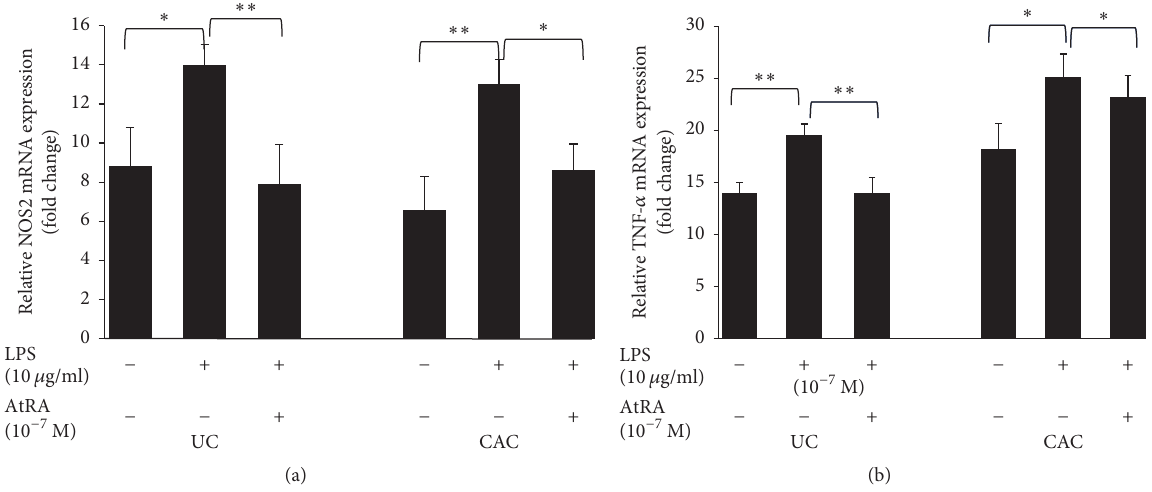
Figure 11: Effect of LPS (10 𝜇 g/ml) in the presence or absence of AtRA (10 −7 M) on NO2 (a) and TNF- 𝛼 (b) mRNA expression in colonic mucosa of patients with active UC and CAC. Values represent mean ± standard deviation. Significance compared with control: ∗ 𝑃 < 0.05 , ∗∗ 𝑃 < 0.01 (UC: ulcerative colitis; CAC: colitis associated cancer).